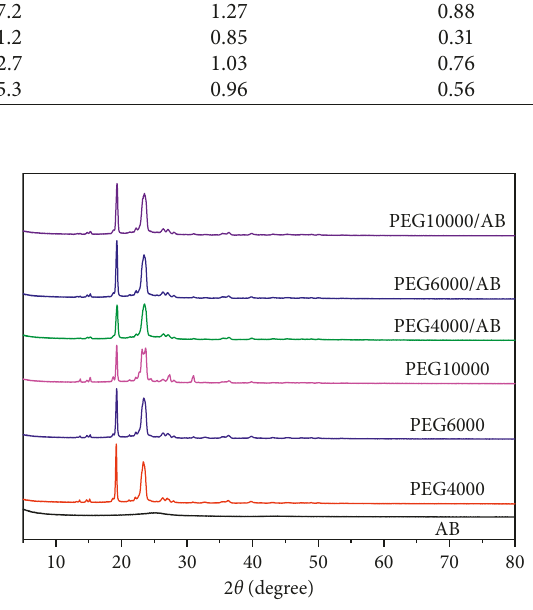
Figure 5: XRD spectra of the AB, pristine PEGs, and PEG/AB